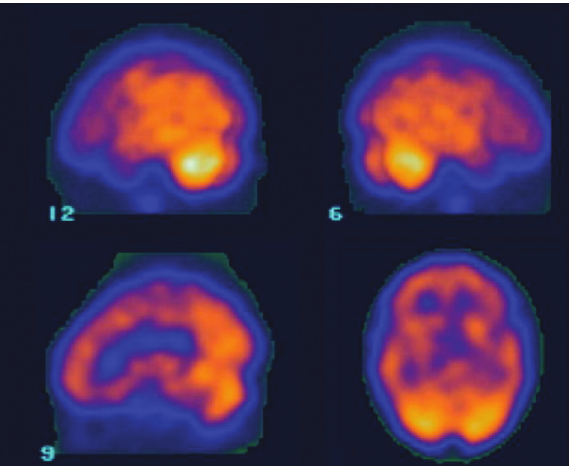
Figure 2. Brain SPECT showing moderate hypoperfusion in frontal